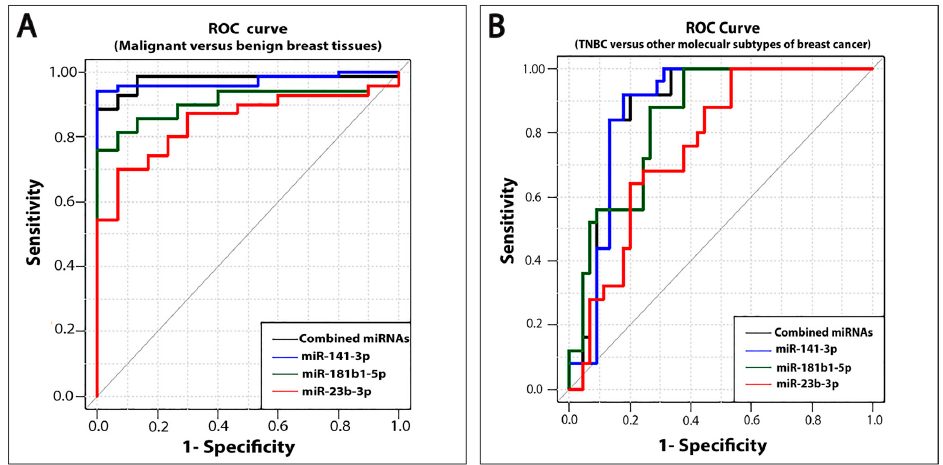
Figure 2. ROC curve analysis of miR-141-3p, miR-181b1-5p, and miR-23b-3p in different groups of breast tissues. ( A ) ROC curve analysis for miR-141-3p, miR-181b1-5p, and miR-23b-3p expression levels individually and combined to discriminate between patients with breast cancer and benign breast fibroadenomas; ( B ) ROC curve analysis for miR-141-3p, miR-181b1-5p, and miR-23b-3p individually and combined to distinguish TNBC from other molecular subtypes of breast cancer. Table 2. ROC analysis of miRNAs in patients with breast cancer compared with benign controls. miRNA Sensitivity Specificity Cuto ff AUC